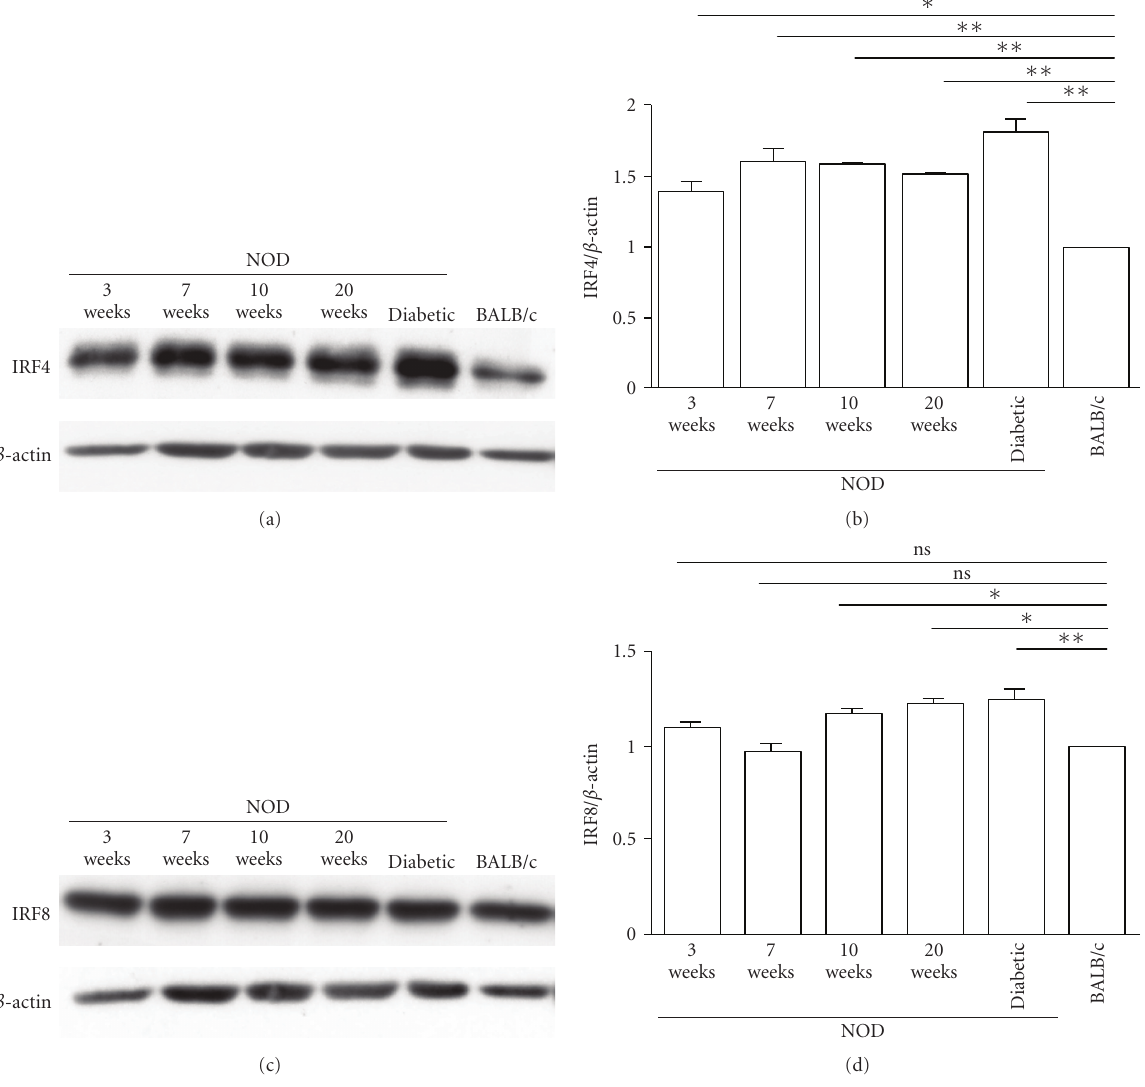
Figure 2: Age-related IRF4 and IRF8 expression levels in splenocytes of diabetes-prone NOD mice and diabetes-resistant BALB/c mice. Proteins were extracted from NOD or BALB/c mouse splenocytes and analyzed by Western blotting for IRF4 (a) or IRF8 (c) expression. The relative intensities of the bands were determined using the NIH Image software and normalized to reference actin bands to establish a ratio of (b) IRF4/actin and (d) IRF8/actin. The levels of expression in BALB/c mice were arbitrarily set at a unitary value. Data are representative of 3 independent